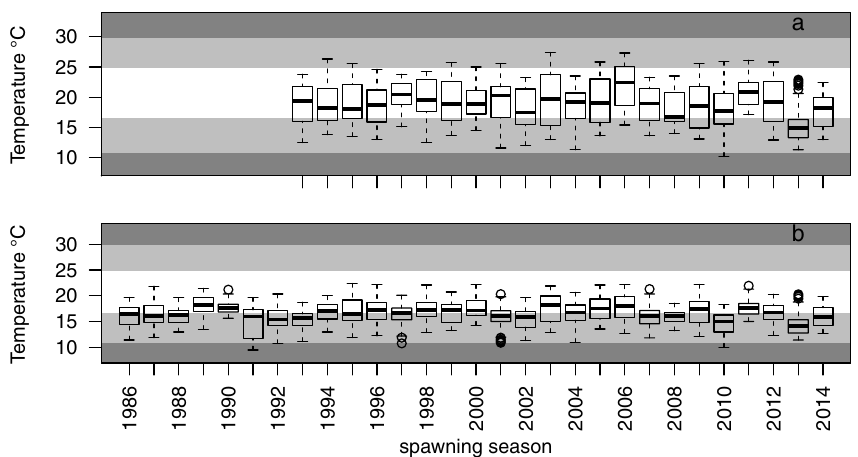
Fig. 4. Distribution of daily temperature between the 1st of May to 15th of July in the Nivelle (a) and the Garonne (b) Rivers. White area indicates temperature within the optimal range, frontiers between dark and light greys indicate the limits of the tolerance